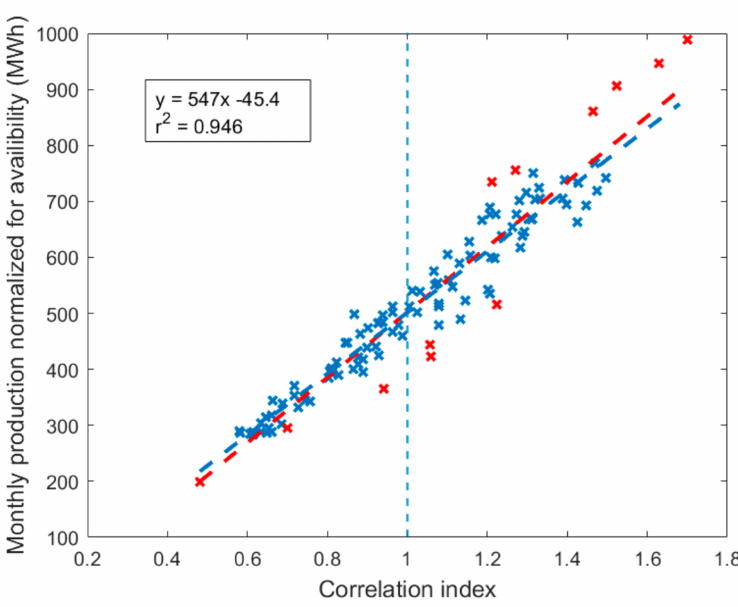
Figure 3. The production values (MWh/month) can be seen plotted against the corresponding (same month and closest index site) ERA5T correlation index. The red values have been excluded by the WCP